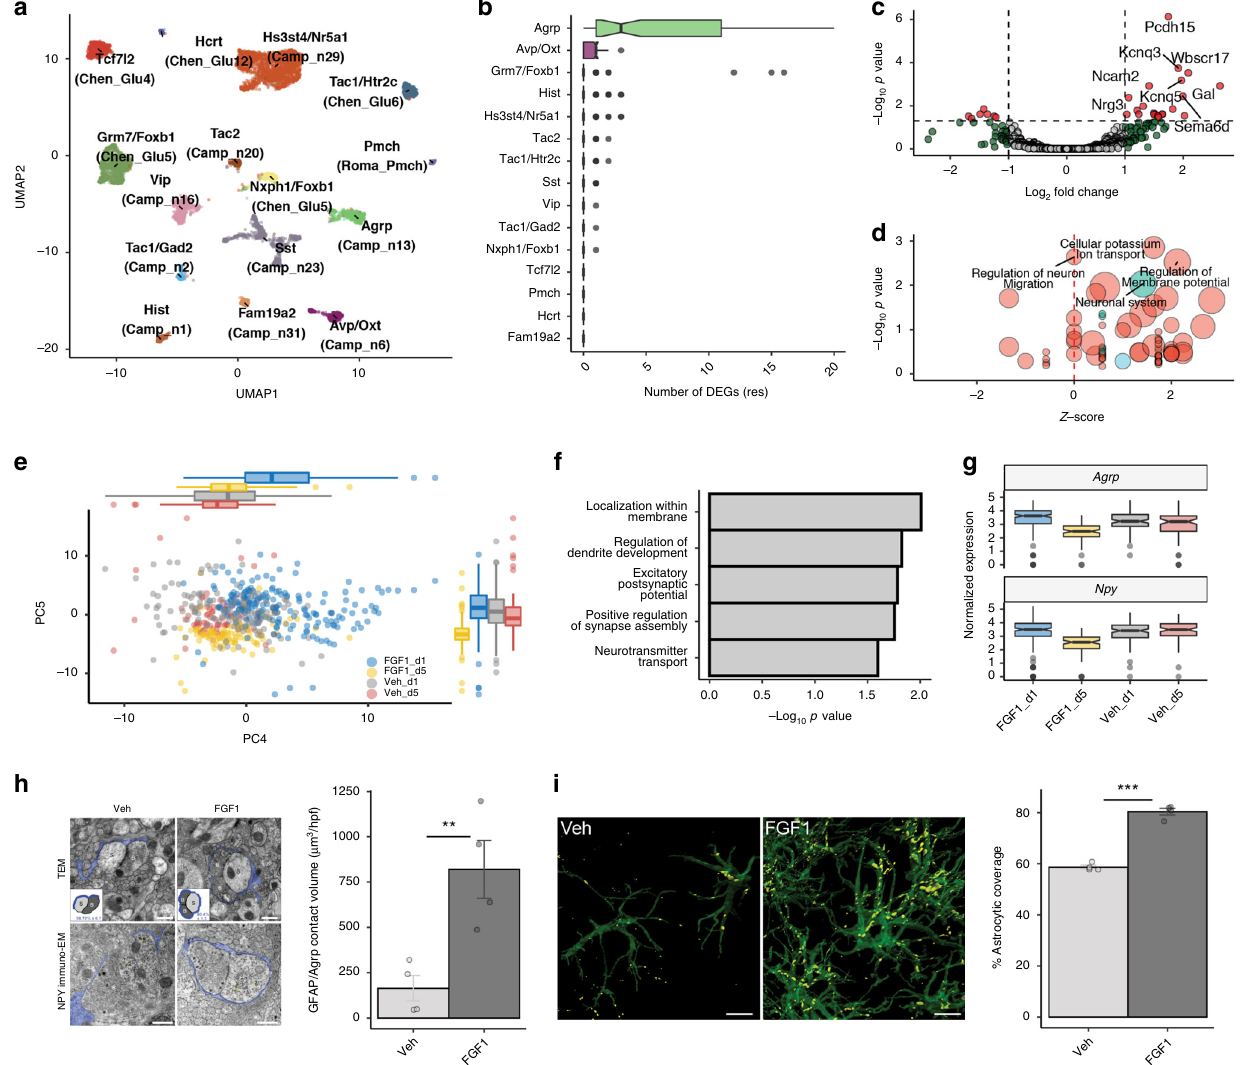
Fig. 5 Effects of icv FGF1 on Agrp neurons. a UMAP clustering of neurons from the snRNA-seq dataset that con fi dently mapped to published datasets 16 – 18 . Original cell type annotations from the published datasets are indicated in brackets. b Numbers of DEGs for neuron subclusters identi fi ed using repeated downsampling (10 cells/group/cell type/iteration, 100 iterations; n = 3 mice/group), median (IQR). c Volcano plot of pseudobulk DEGs in Agrp neurons from the Day 1 snRNA-seq dataset between FGF1 and vehicle. Red, genes with FDR < 0.05 and |log 2 fold change| > 0.25; green, genes with an |log 2 fold change|> 0.25; gray, genes below both thresholds. d Gene Ontology (biological process; red) and REACTOME (blue) terms enriched for DEGs in Agrp neurons at Day 1. Circle size denotes gene overlap with the identi fi ed geneset. e Principal component analysis of Agrp neurons sampled at Days 1 and 5 (vehicle and FGF1) revealed strong separation from other groups at PC4 and PC5, respectively ( n = 3 mice/group Day 1, n = 2 mice/group Day 5), median (IQR). f Gene Ontology term (biological processes) of highly loading genes on PC5. g Normalized expression of Agrp and Npy in Agrp neurons across the 4 groups (FGF1, Days 1 and 5; vehicle, Days 1 and 5; n = 3 mice/group Day 1, n = 2 mice/group Day 5). h Top panel: representative electron microscopic images of coverage of synapses between axonal boutons (B) and dendritic spines (S) by peri-synaptic astrocytic in the ARC area of Lep ob/ob mice. Bottom panel: immunostaining for Npy . Scale bar 500nm. Quanti fi cation: dots represent percentage of astrocytic coverage for individual animals (mean of 30 synapses per animal, n = 4/group), mean± SEM. Unpaired t test, two tailed, *** p < 0.0001 (not adjusted). i Contacts between GFAP( + ) astrocytes (green) and Agrp( + ) neurons in the ARC area (equivalent to outline in g ) 1 week following icv FGF1 or vehicle injection of Lep ob/ob . Yellow represents co- labeled GFAP-positive and Agrp-positive voxels. Scale bar 8 μ m. Pixel dimensions: 0.057 × 0.057 × 0.500 microns. Quanti fi cation: dots represent mean contact volume over high power fi eld (hpf: 116.5× 116.5 microns) for individual animals (2 sections per animal, n = 4/group), mean± SEM. Unpaired t test, two tailed, ** p = 0.0093 (not adjusted). Source data and summary statistics are provided as a Source data fi